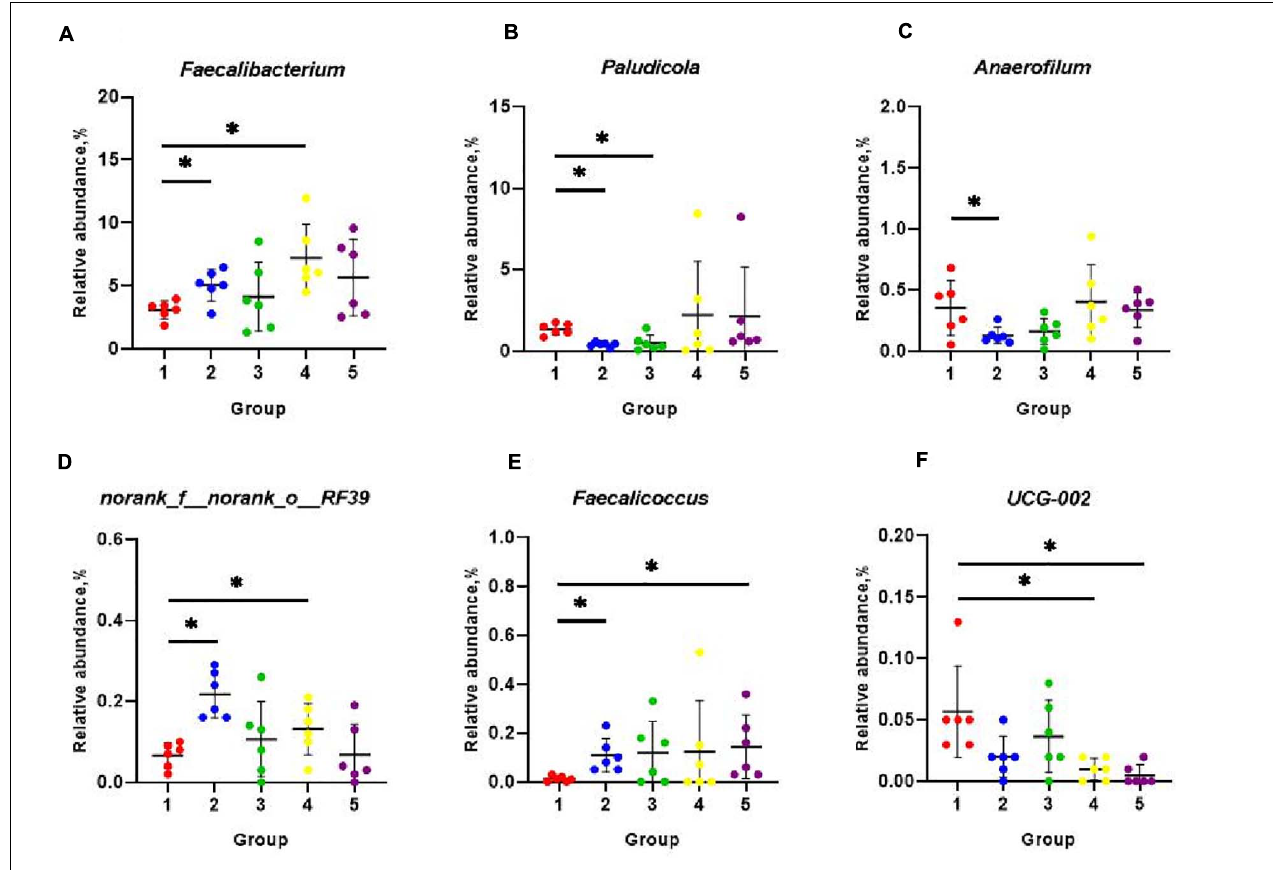
FIGURE 4 | Classification and differences in cecal microbial composition at the genera level among five groups. The relative abundance of microbial genera that significantly altered included Faecalibacterium (A) , Paludicola (B) , Anaerofilum (C) , norank_f_norank_o_RF39 (D) , Faecalicoccus (E) , and UCG-002 (F) . Data were shown as means ± SD ( n = 6), * P < 0.05 compared with Group